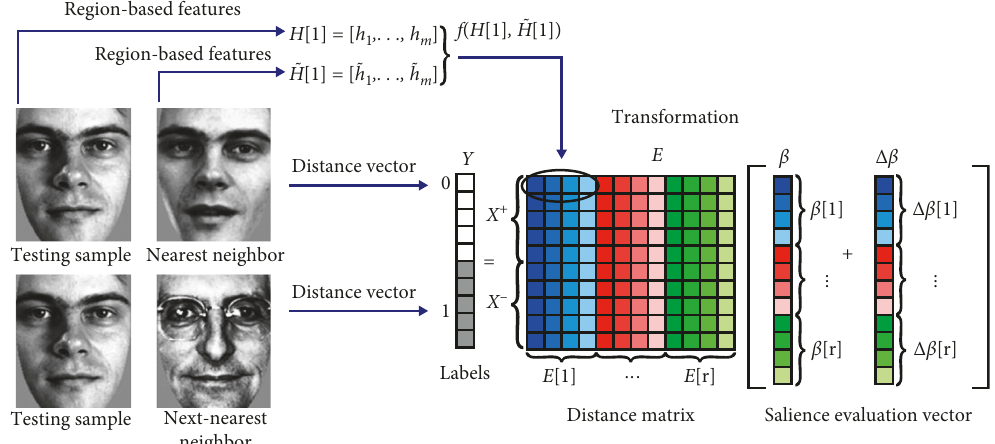
Figure 1: Visual expression of facial feature transformation and theory for constructing the linear system.